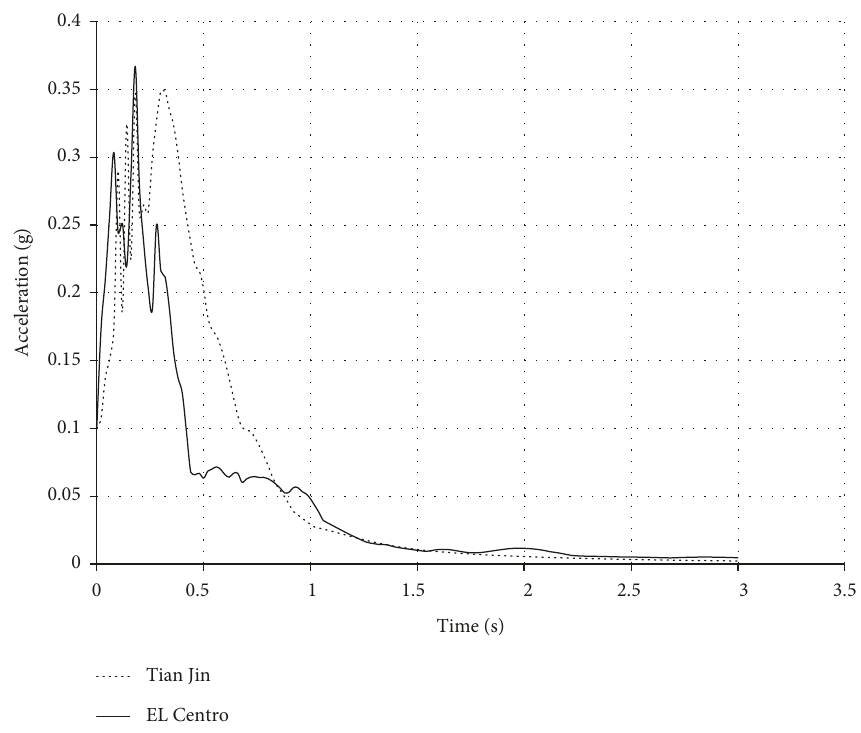
Figure 5: Acceleration response spectra of input